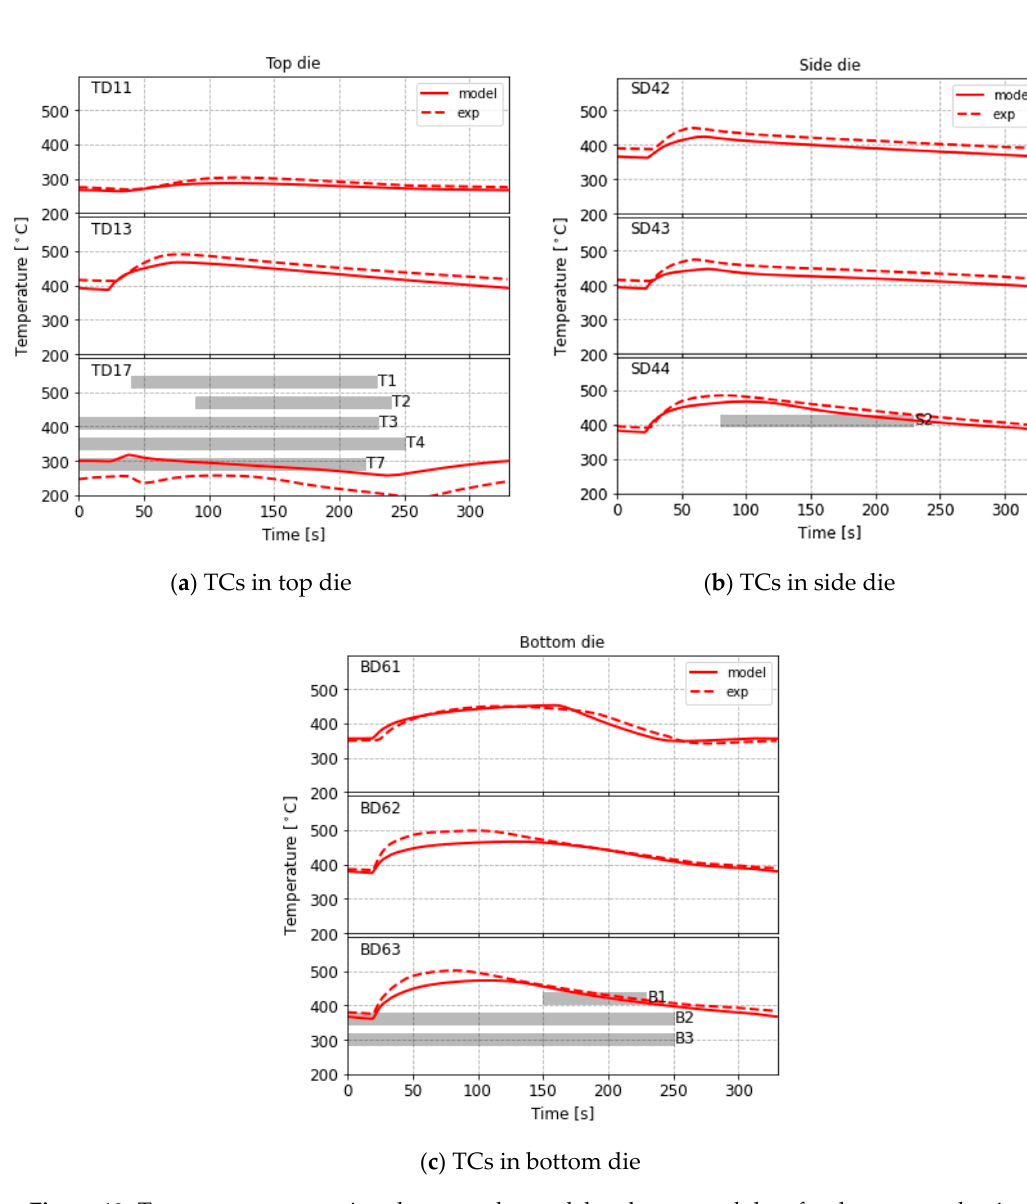
Figure 10. Temperature comparison between the model and measured data for the non-production process condition in Die-A.